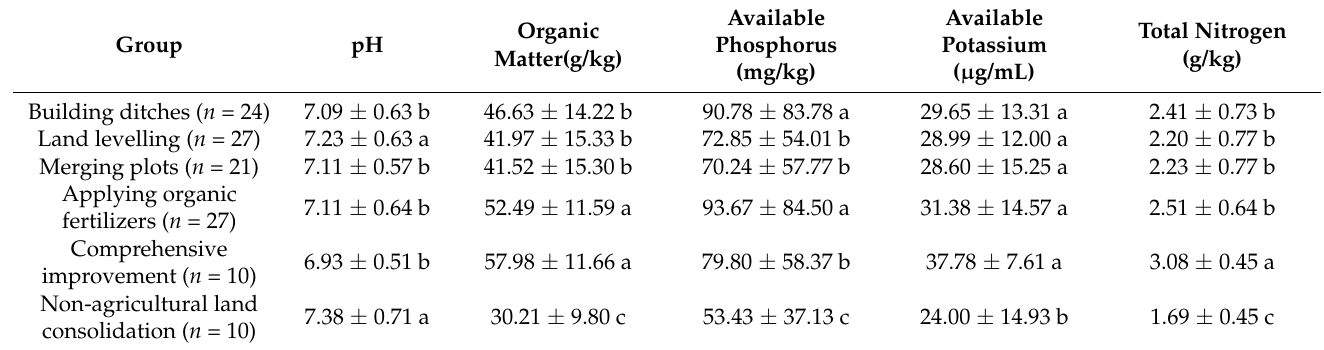
Table 3. The chemical properties of soil (0–15 cm) between different groups in the study